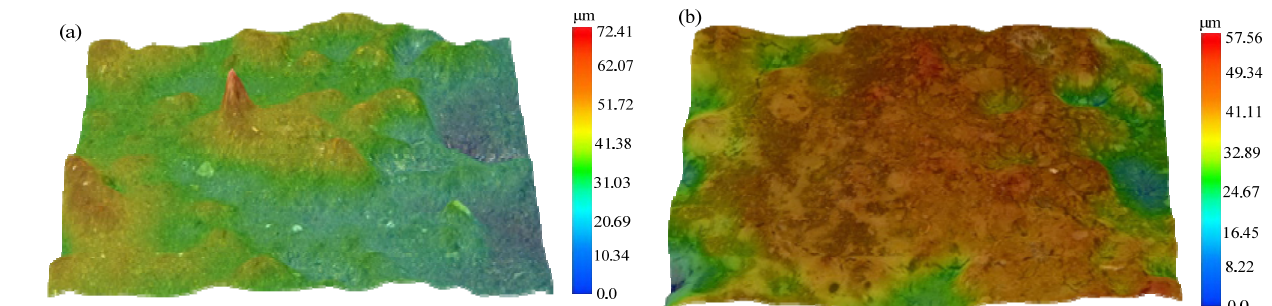
Figure 11. 3D morphology of grinding wheel surface. ( a ) A = 0 μ m, C-ELID; ( b ) A = 12.5 μ m, UA-ELID.